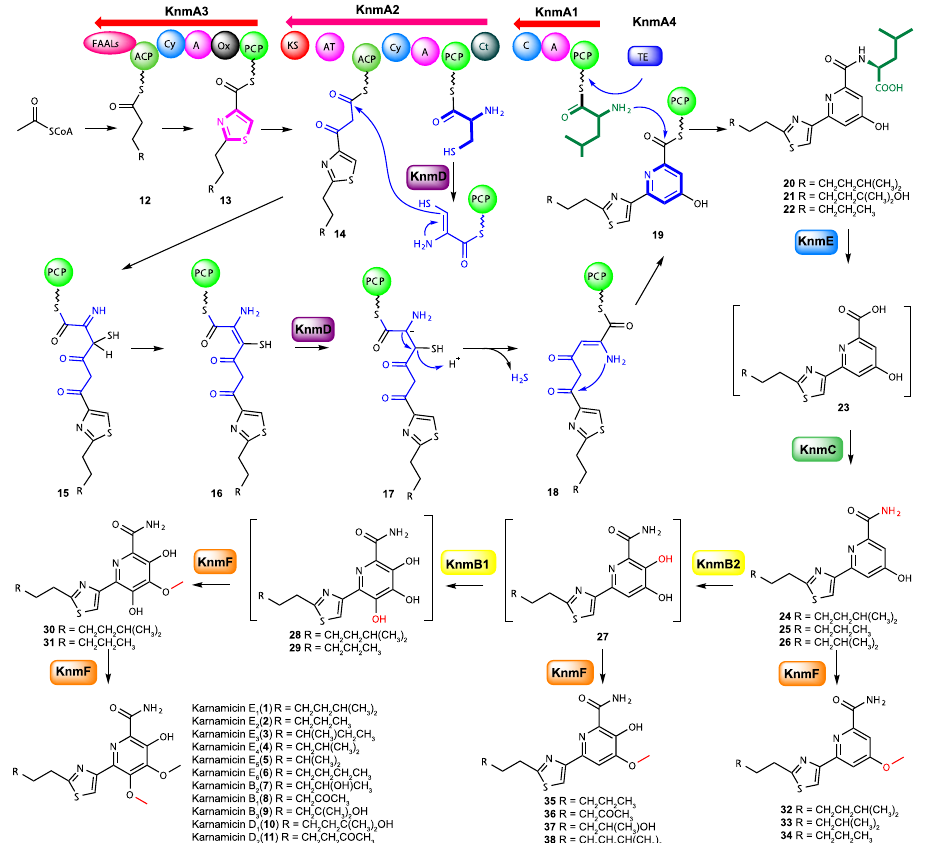
Fig. 3 | Proposed biosynthetic pathway for karnamicins. FAALs fatty acyl-AMP ligases, ACP acyl carrier protein, Cy condensation/cyclization domain, A adenyla- tiondomain,Ox fl